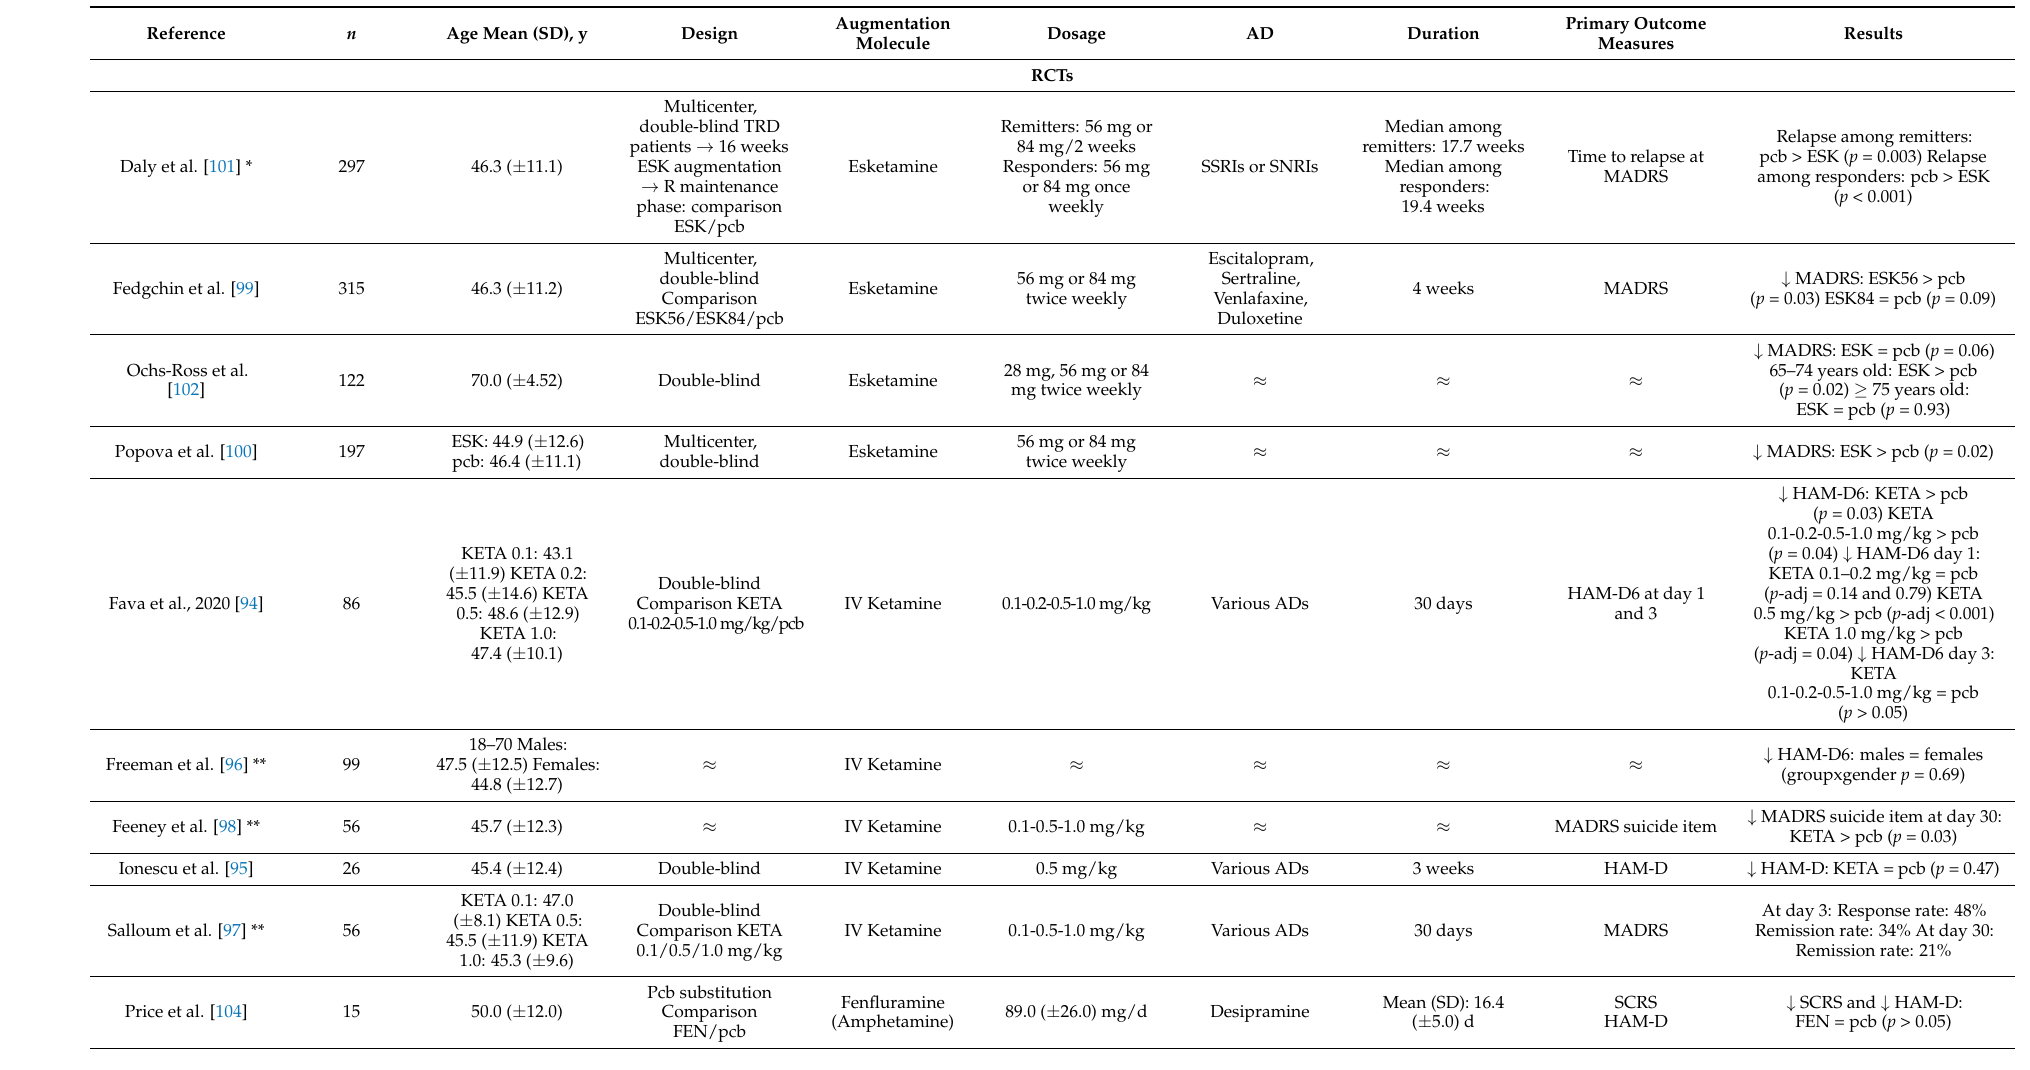
Table 5. Summary of the studies about augmentation with IV ketamine, esketamine nasal spray, and psychostimulant drugs in